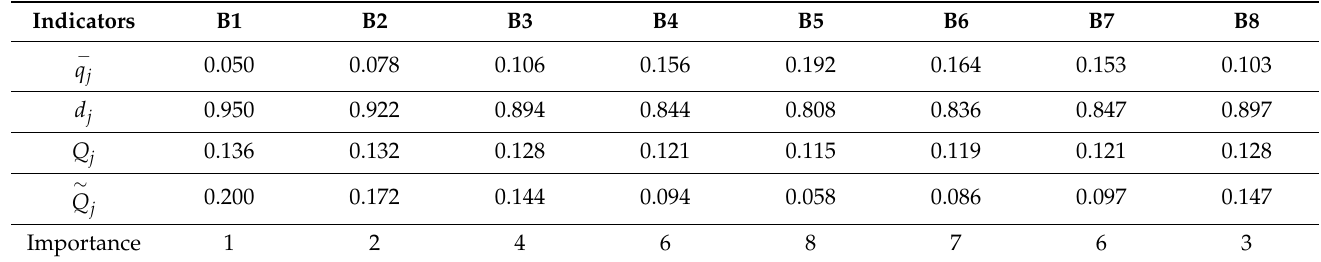
Table 5. Distribution of indicators according to importance.